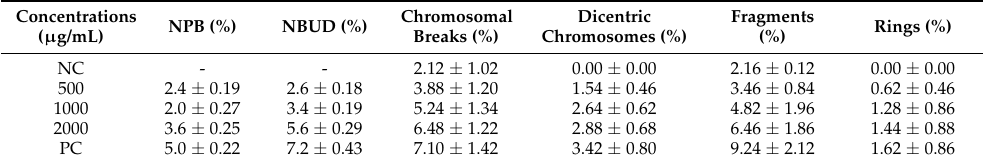
Table 1. Frequency of NPB, NBUD, and different chromosomal aberrations, such as chromoso- mal breaks, dicentric chromosomes, fragments, and rings in lymphocytes, treated with different concentrations of PSNPs after 48 h of